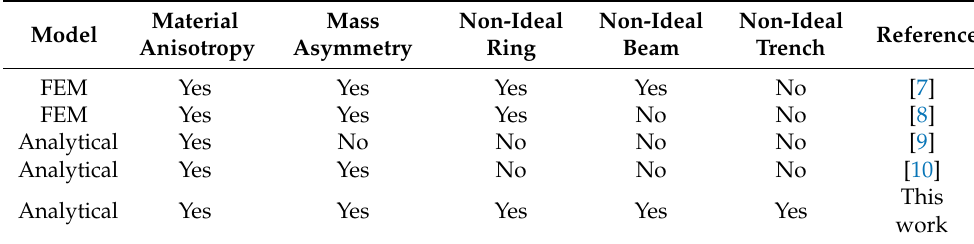
Table 1. Models of ring-based